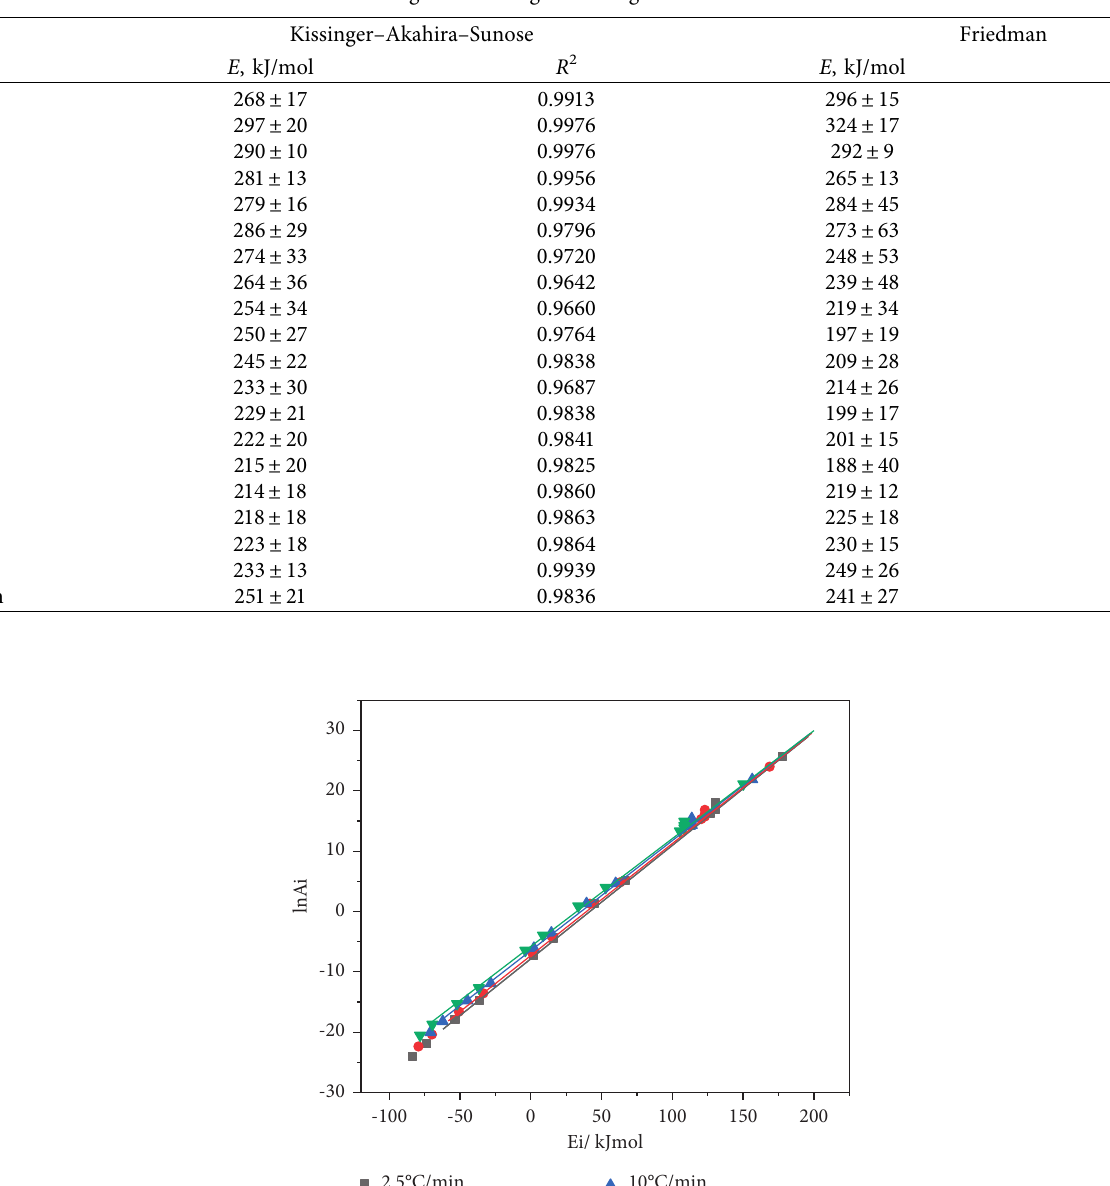
Table 3: Activation energies according to Kissinger–Akahira–Sunose and Friedman.